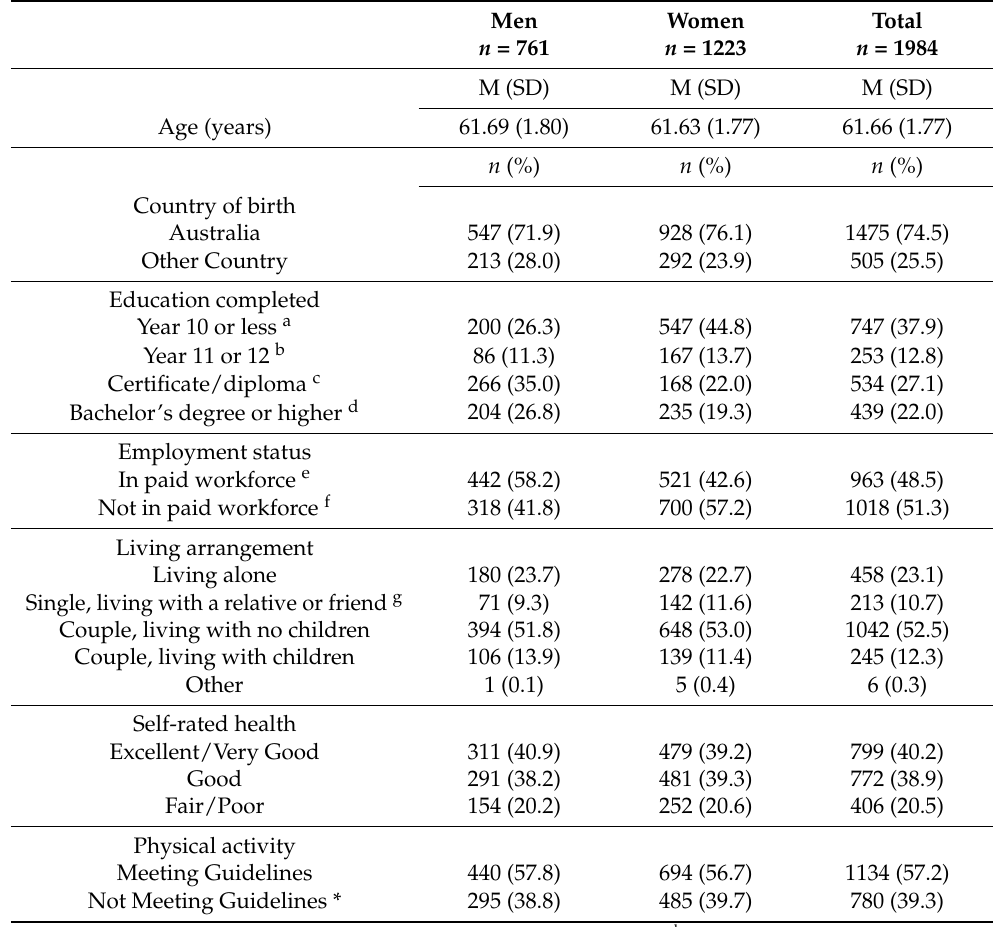
Table 1. Summary demographics of current study sample at baseline, by gender ( n =